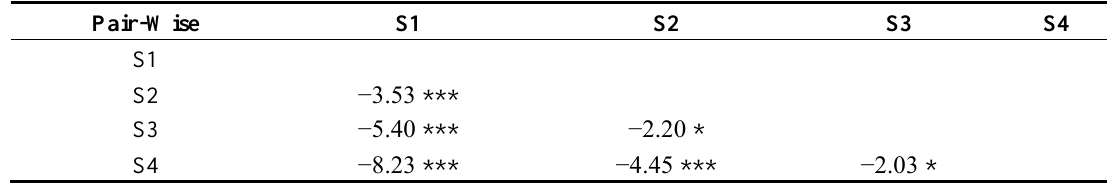
Table 13. Pair-wise Z statistic test of the comparisons of the different classification strategies in the southern study